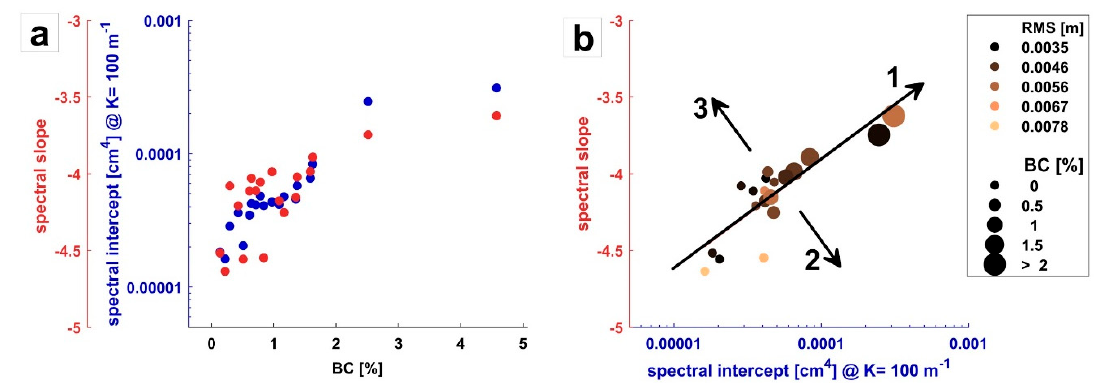
Figure 7. ( a ) Spectral slopes and intercepts displayed against the benthic coverage. Grain size is constant at 2.6 phi. ( b ) A slope vs. intercept diagram for the study site. Symbol color denotes RMS roughness, symbol size denotes the benthic coverage in percent. Arrow 1: Effect of increasing high-frequency roughness due to benthic life (this study). Arrow 2: Effect of relative decrease of low-frequency roughness [9]. Arrow 3: Effect of the relative increase of low-frequency roughness [9].